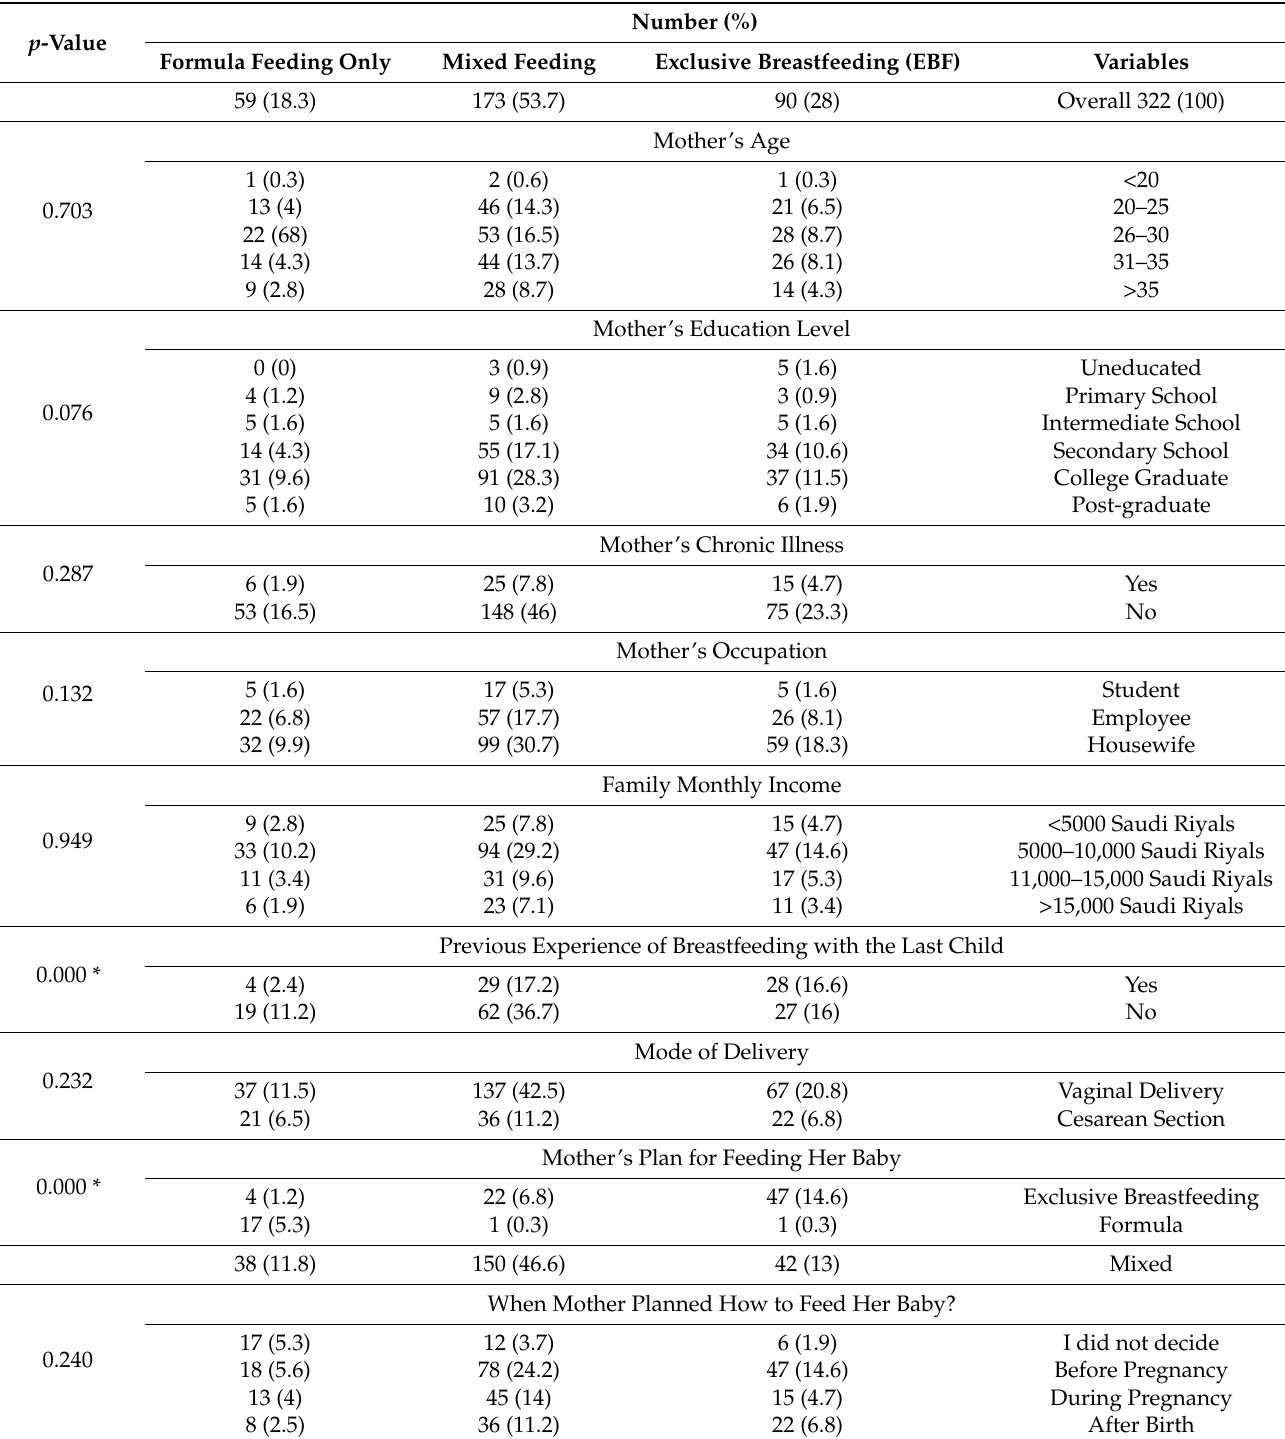
Table 1. Sociodemographic, health-related characteristics, and practices of the sample of surveyed mothers in relation to their feeding patterns for their infants for the first six months of their infants’ lives in Riyadh, Saudi Arabia. p